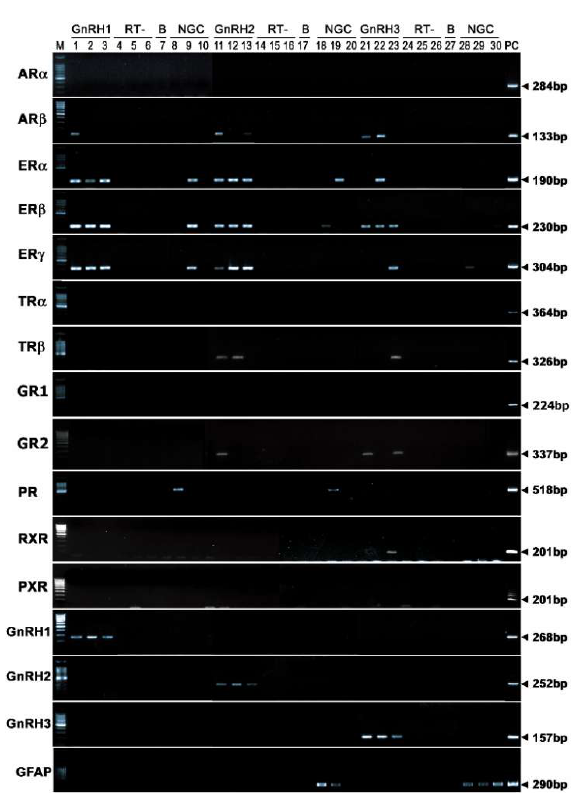
Figure 3. Composite gel showing GnRH and nuclear receptor mRNA expression in the three GnRH subtypes neurons taken from aggressive males (GnRH1, lane 1–3; GnRH2, lane 11–13; GnRH3, lane